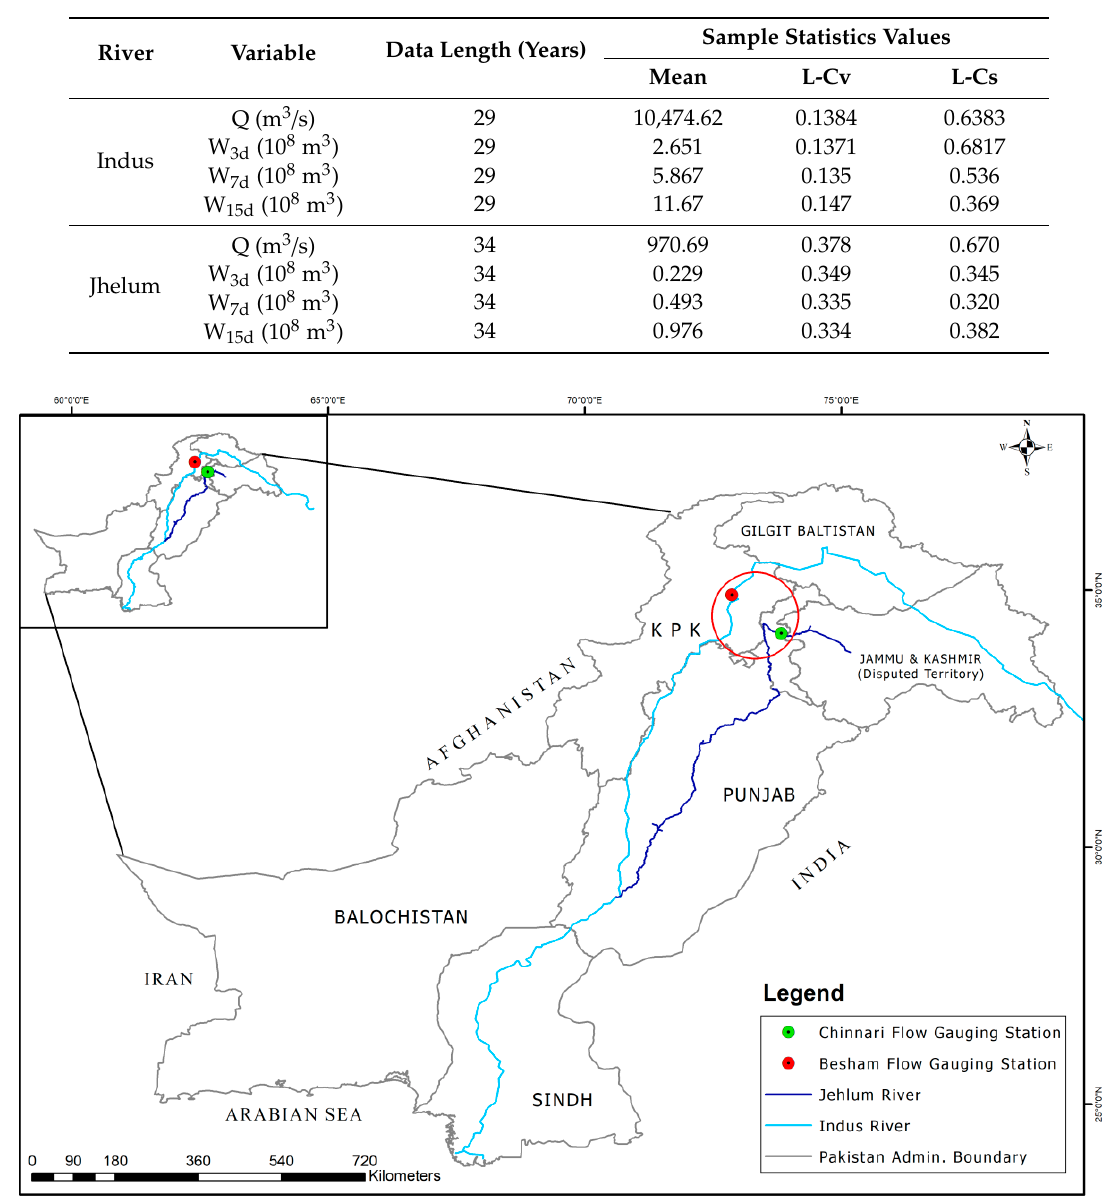
Figure 1. Location of the study area in the Indus basin system of Pakistan.